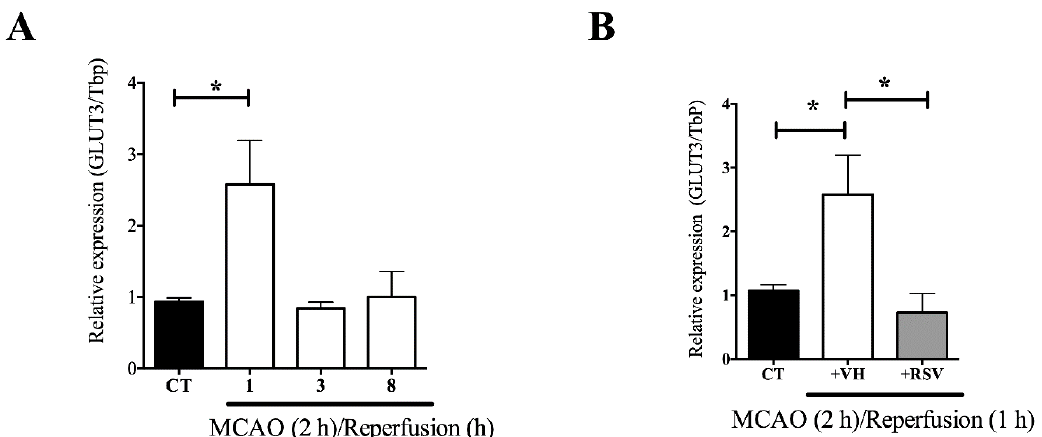
Figure 2. Resveratrol prevents the ischemia induced glucose transporter 3 (GLUT3) mRNA up-regulation in the brain. Rats were subjected to middle cerebral artery occlusion (MCAO) during 2 h followed by restoration of blood flow (reperfusion) for 24 h. Control animals (CT) were subjected to simulated MCAO. At the onset of restoration of blood flow, animals received either vehicle, ethanol 50% (+VH) or resveratrol at 1.9 mg/kg, body weight (+RSV). Relative mRNA expression was measured by quantitative PCR. ( A ) GLUT3 mRNA levels after MCAO and different times of reperfusion. ( B ) The effect of resveratrol on GLUT3 mRNA levels induced after MCAO and 1 h reperfusion. Values of expression were expressed as mean ± standard deviation. ANOVA, Tukey, * p < 0.05.